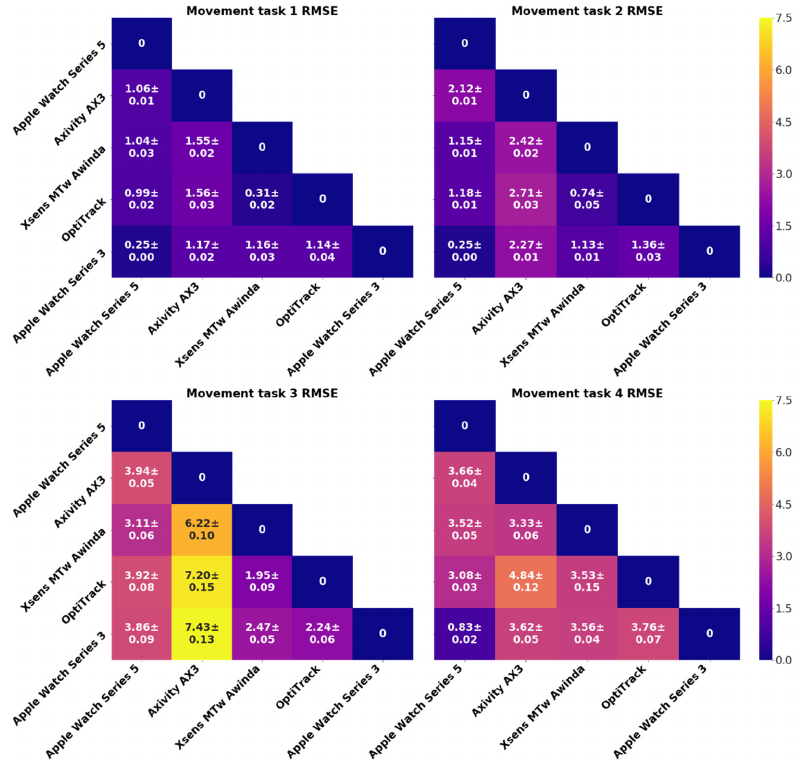
Figure A3. Depicts a breakdown of the acceleration RMSE result in Figure 4b for each of the 4 movement tasks. Displayed RMSE in the figure are rounded. The unit is m·s − 2 .